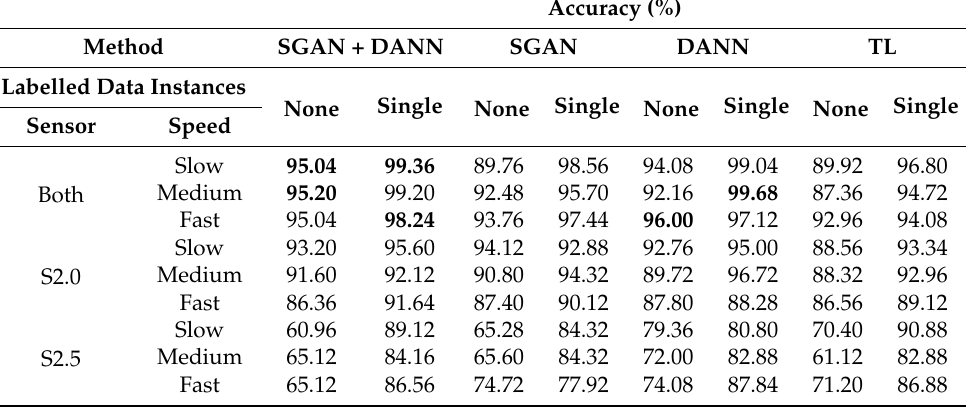
Table 2. The accuracies (%) for each domain-adaptation methodology on the test set acquired under moving conditions for each speed. A comparison between using both sensors and each sensor individually is provided. A comparison to using transfer learning (TL) with no domain-adaptation methodology is included. None or single in the labelled data instances row indicates whether no labelled data from the spectra acquired under moving conditions was used in the training set or if a single labelled instance from each material was included. The bolded results show the highest accuracies achieved for each task (i.e., combination of speed and number of labelled target domain data